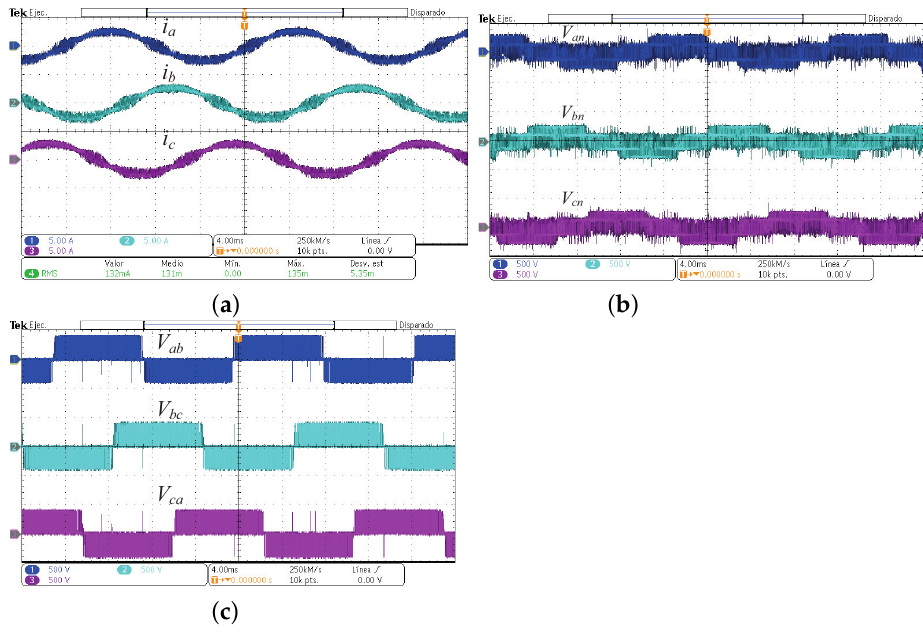
Figure 15. Experimental output currents and voltages of the three-phase DCM-232 inverter under the SVM-CSSVM technique. ( a ) Output currents, ( b ) line-to-neutral voltages, and ( c ) line-to-line voltages.